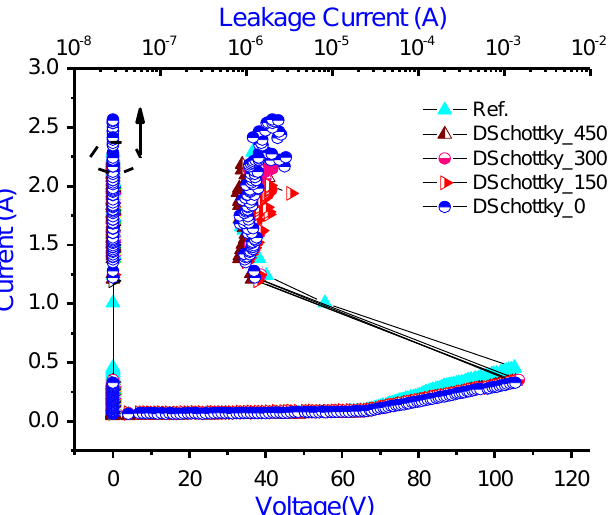
Figure 8. Snapback I-V curves and leakage currents of HV nLDMOSs with the drain electrode-embedded horizontal Schottky length modulation.